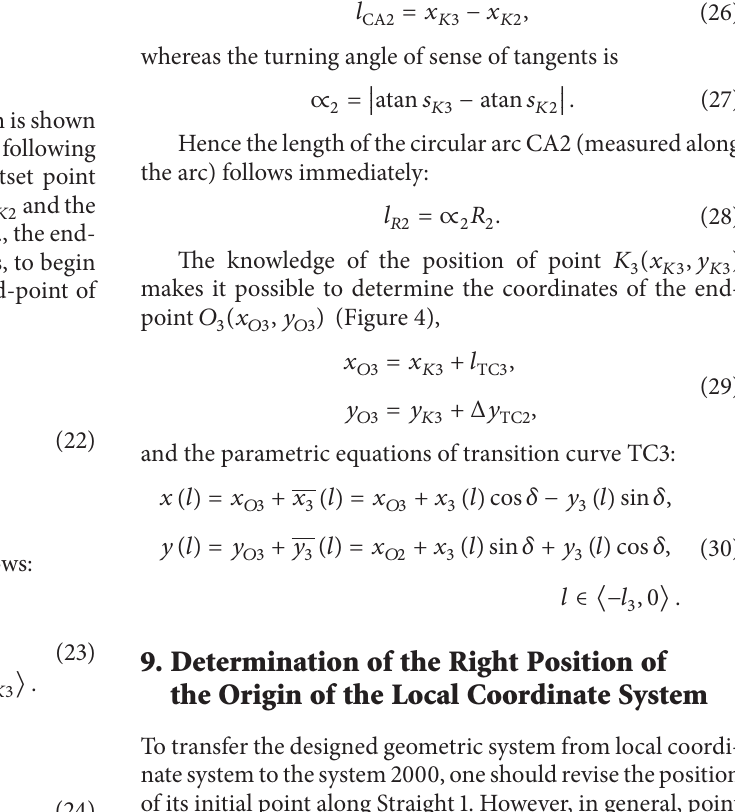
Figure 5: Effective scheme of the circular arc CA2 position.